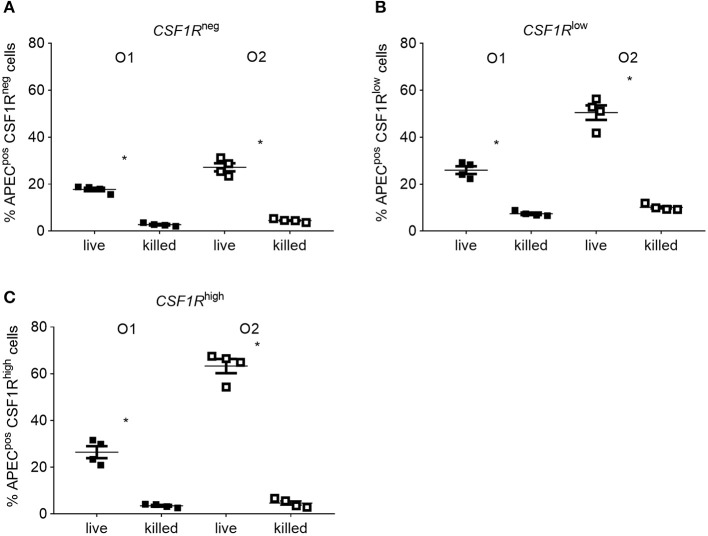
In vitro flow cytometric analysis of APECpos lung cells after inoculation with live or heat killed APEC. Gradient purified lung cells were isolated from 6 to 8 weeks old CSF1R-reporter transgenic birds and inoculated with an MOI = 10 of either live or heat killed APEC O1-GFP or APEC O2-GFP. (A–C) Quantification of APECpos cells in the CSF1R-tgneg, CSF1R-tglow, and CSF1R-tghigh cells. O1 is APEC O1-GFP, O2 is APEC O2-GFP. n = 4 birds from two independent studies. The mean with SEM is shown. *P < 0.05.